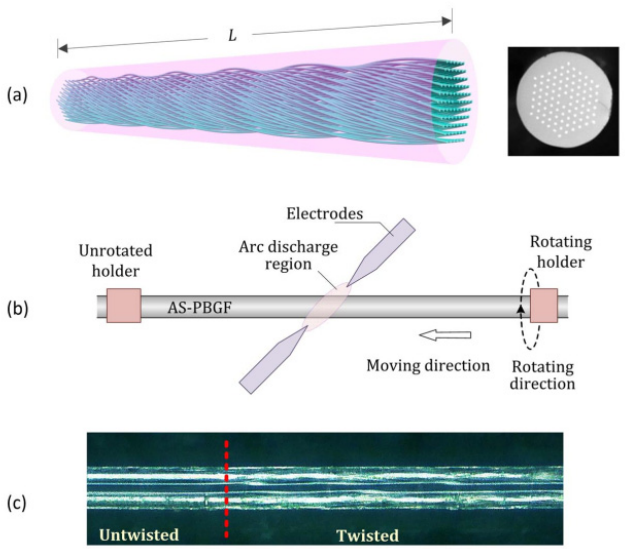
Figure 13. Few-period helically twisted all-solid PBGF fabricated by using arc discharge method. ( a ) Schematic of the helically twisted AS-PBGF, where the inset shows the scanning electron micrograph of the cross section. ( b ) Experimental setup. ( c ) Microscopic images for side-view of the twisted and untwist AS-PBGFs. Adapted with permission from Ref. [22] © The Optical Society.